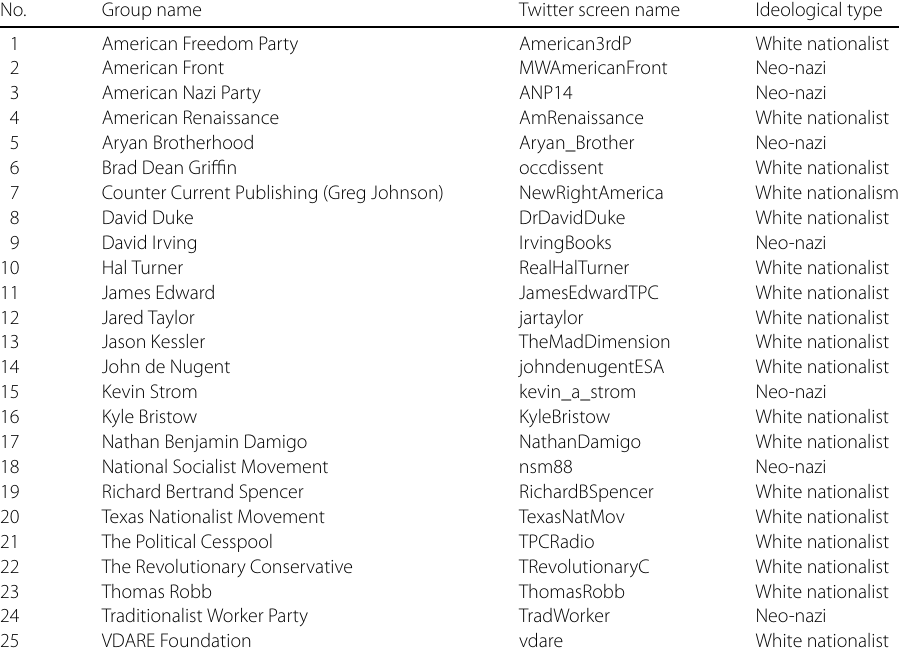
Table A1 List of white nationalist and neo-nazi groups in the U.S. who have active Twitter